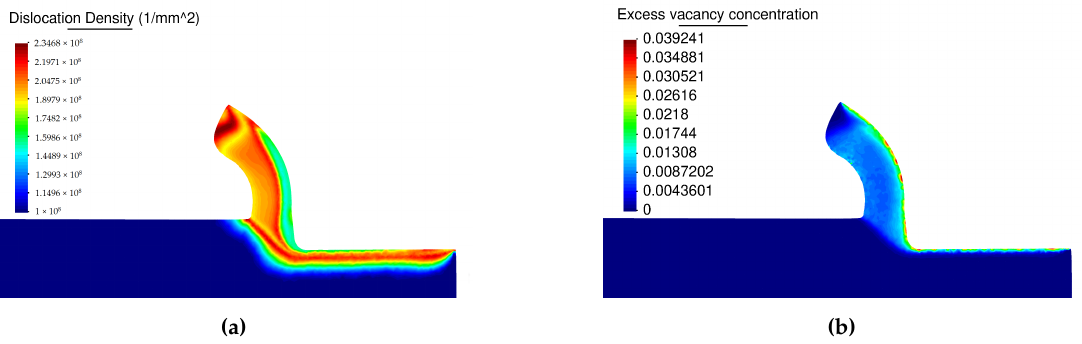
Figure 17. State variables obtained from the dislocation density (DD) model; ( a ) dislocation density, ( b ) vacancy